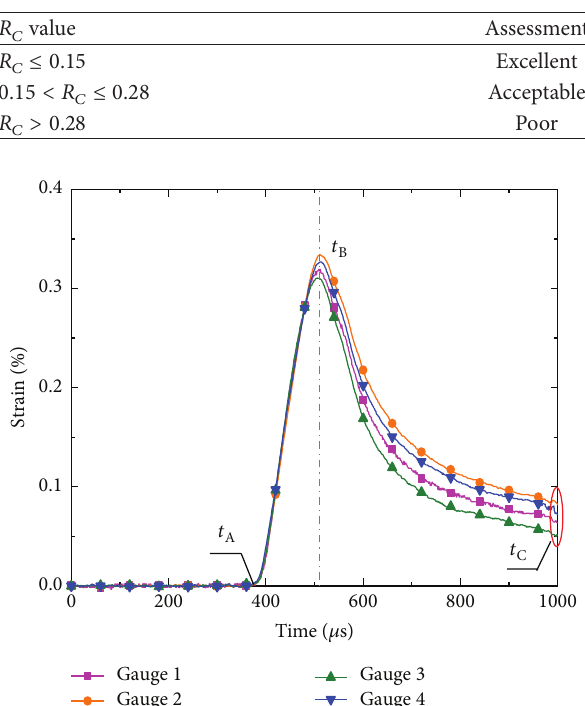
Table 2: Acceptance criteria for the Russell comprehensive error factor.